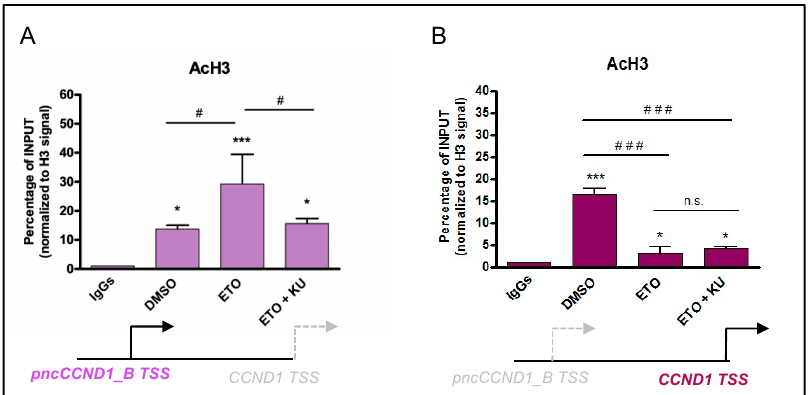
CCND1 TSS pncCCND1_B TSS Figure 5. Histone acetylation of CCND1 promoter upon etoposide treatment. Histone acetylation was evaluated by ChIP analysis upon DMSO (vehicle), 5 µM etoposide (ETO), or etoposide with pre-treatment of 10 µM of KU 55933 (ETO + KU). The acetylated status of the promoter was meas- ured by qPCR analysis at the pncCCND1_B promoter (upstream region, ( A )) and at a downstream region ( B ), close to transcription start site (TSS) of the CCND1 gene. p -value was evaluated by ANOVA with Bonferroni correction (*, # < 0.05, ***, ### < 0.005, n.s. >